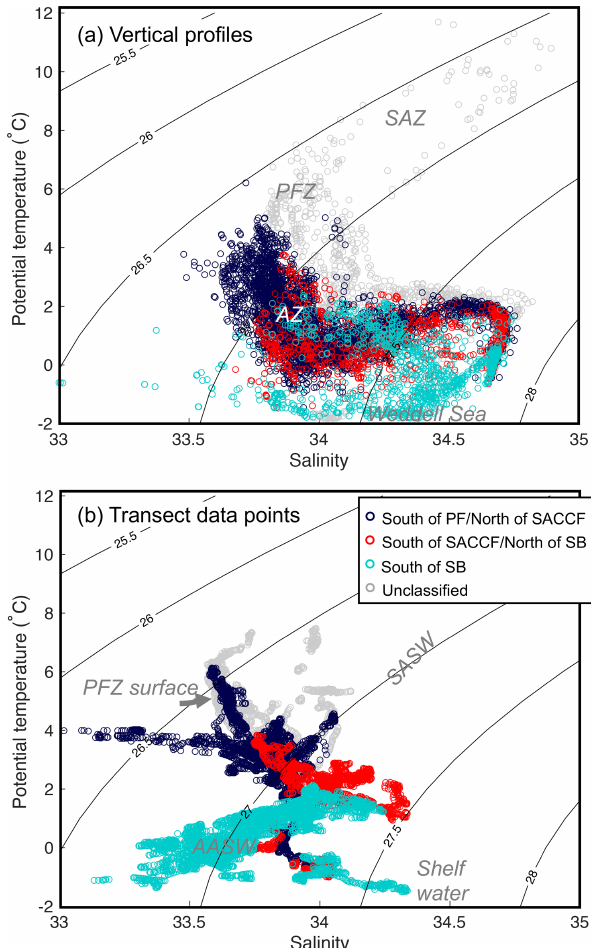
Figure 6. Potential temperature–salinity plots for (a) CTD verti- cal profiles and (b) transect data points. Data have been colour coded according to their location relative to the long-term mean po- sitions of the PF, SACCF and SB (see Fig. 1). SAZ: Subantarctic Zone, PFZ: Polar Frontal Zone, SASW: Subantarctic Surface Wa- ter, AASW: Antarctic Surface